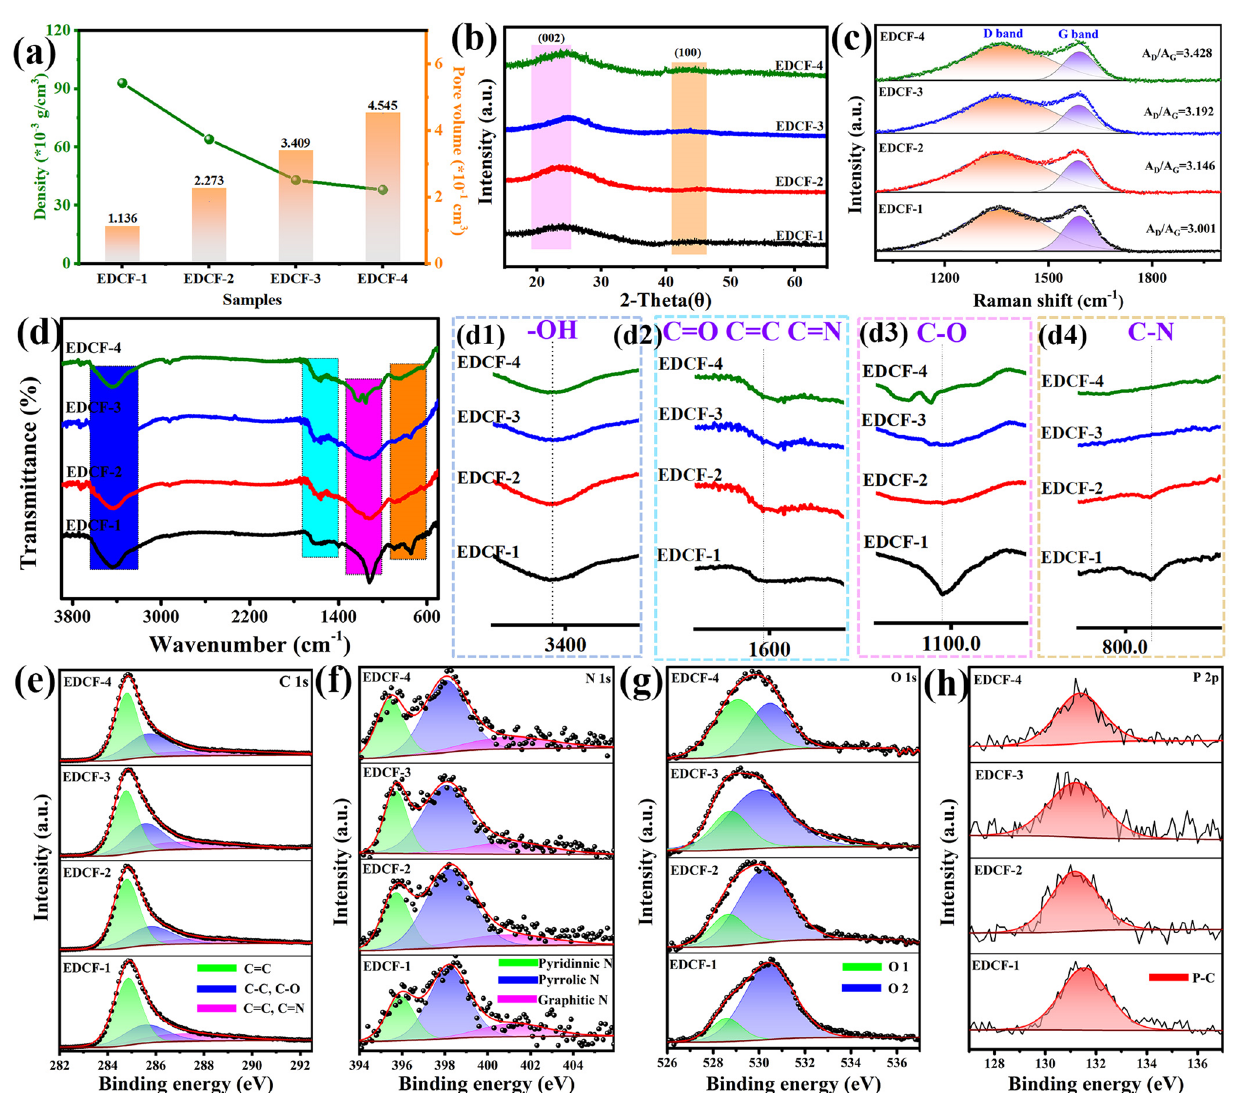
Fig. 2 a Variation of density, pore volume and specific surface area of EDCF samples with different addition amount of 200 nm silica micro- spheres; b XRD patterns, c Raman spectra, d FT-IR spectra and partial enlarged images of FT-IR captured from marked area in Fig. 2d (d1 ~ d4); high-resolution XPS spectra of e C 1 s , f N 1 s , g O 1 s and h P 2 p of EDCF-1 ~ EDCF-4